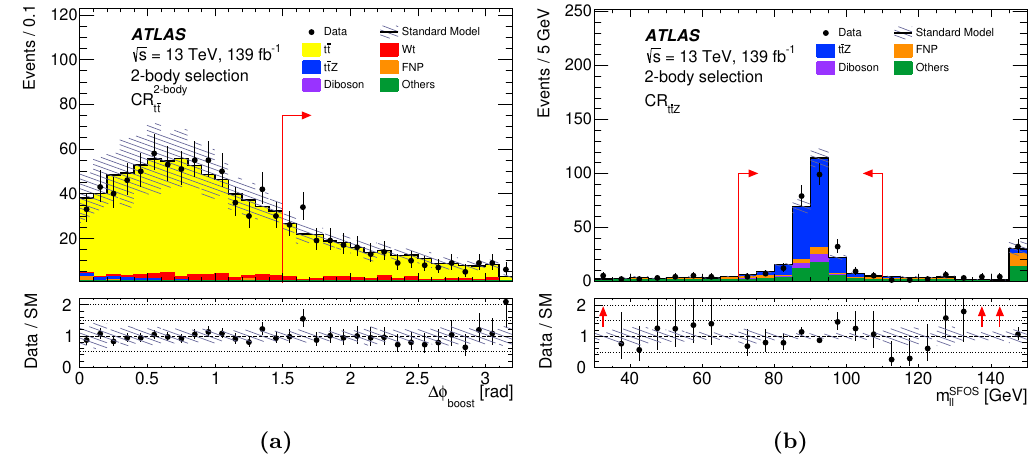
Figure 2 . Two-body selection. Distributions of (a) ∆ φ two same-flavour and opposite-charge leptons candidate in CR The contributions from all SM backgrounds are shown as a histogram stack. “Others” includes the contributions from V V V , tt t , tttt , tt W , tt WW , tt WZ , tt H , and tZ . The hatched bands represent the total statistical and detector-related systematic uncertainty. The rightmost bin of (b) includes overflow events. In the upper panels, red arrows indicate the control region selection criteria. The bottom panels show the ratio of the observed data to the total SM background prediction, with hatched bands representing the total uncertainty in the background prediction; red arrows show data outside the vertical-axis range.